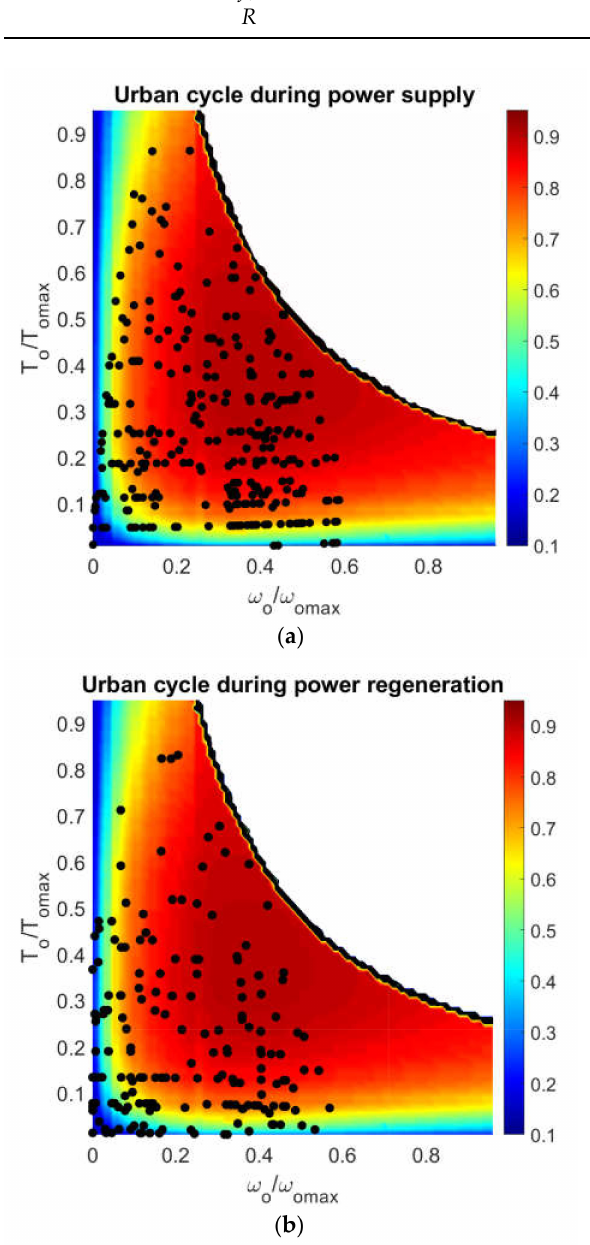
Figure 6. Working points of the Artemis drive cycle (DC) overlaid over the efficiency map during: ( a ) power supply; and ( b ) power